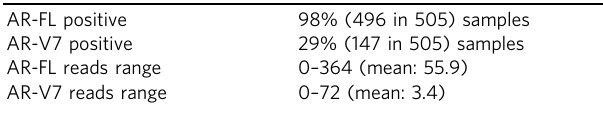
Table 2 Prevalence of AR-FL and AR-V7 in large RNA-Seq data sets from patients with primary or metastatic prostate